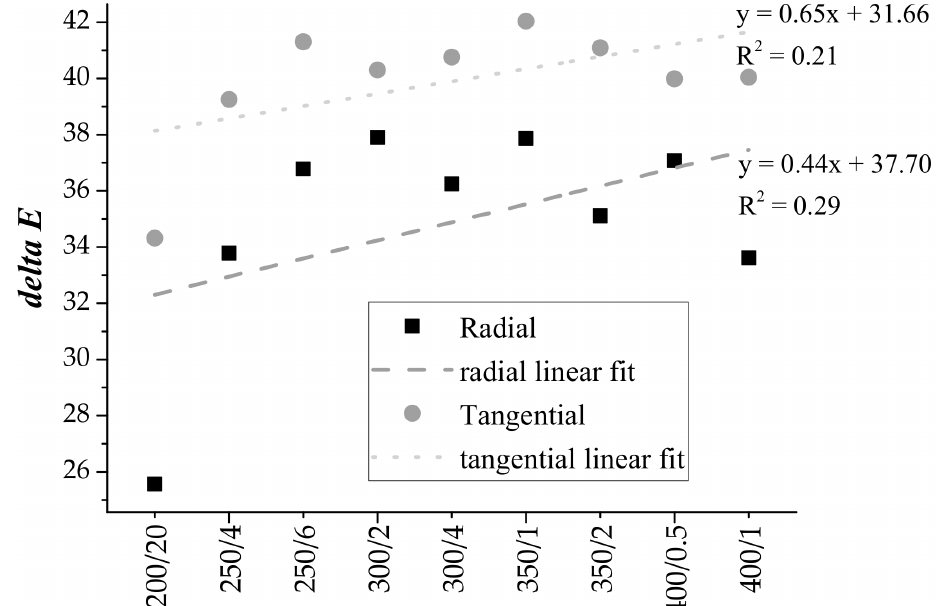
Figure 2. Comparison of colour changes ∆ E in radial and tangential